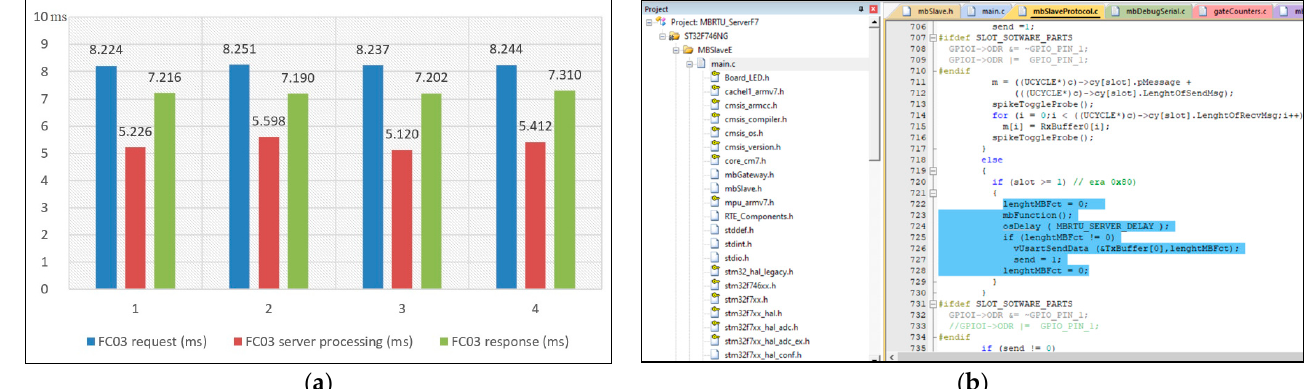
Figure 7. Measured times and microcontroller software application: ( a ) measured times correspond- ing to FC03 and FC16 Modbus functions; ( b ) Modbus server protocol development using Keil uVision environment.